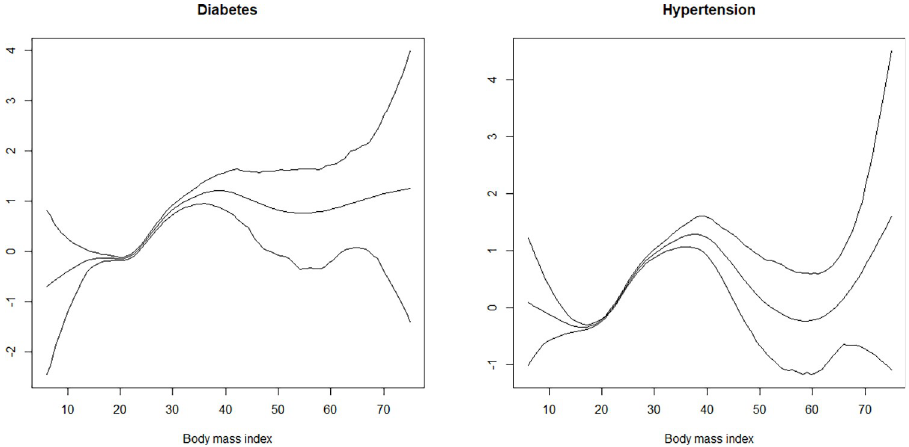
Fig 2. Non-linear effects of body mass index on the log-odds of diabetes and hypertension (the figure shows posterior means along with the 97.5% credible intervals).